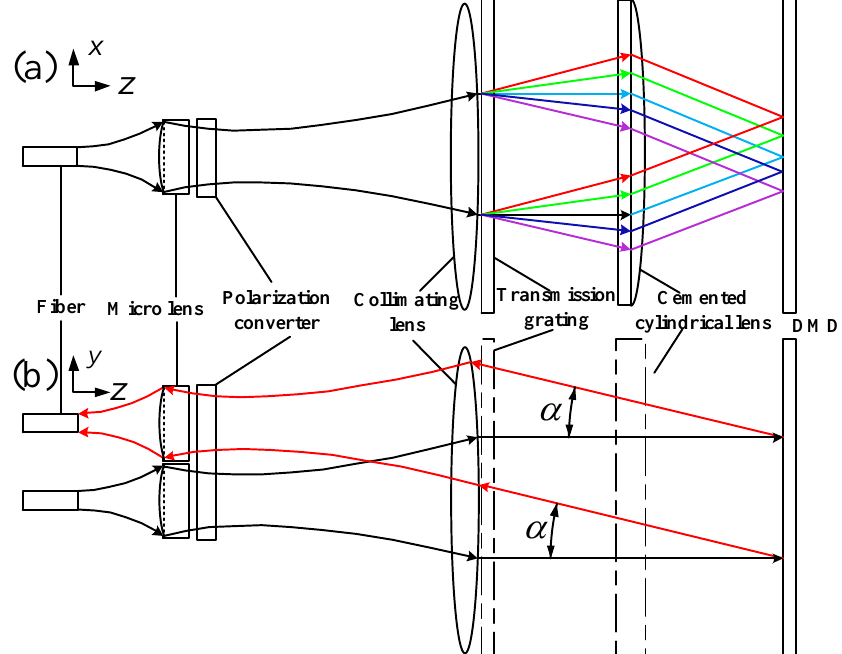
Figure 2. Layout of the filter optics: ( a ) The view in xz -plane showing light being de-multiplexed ( b ) The view in yz -plane showing light deflected by a